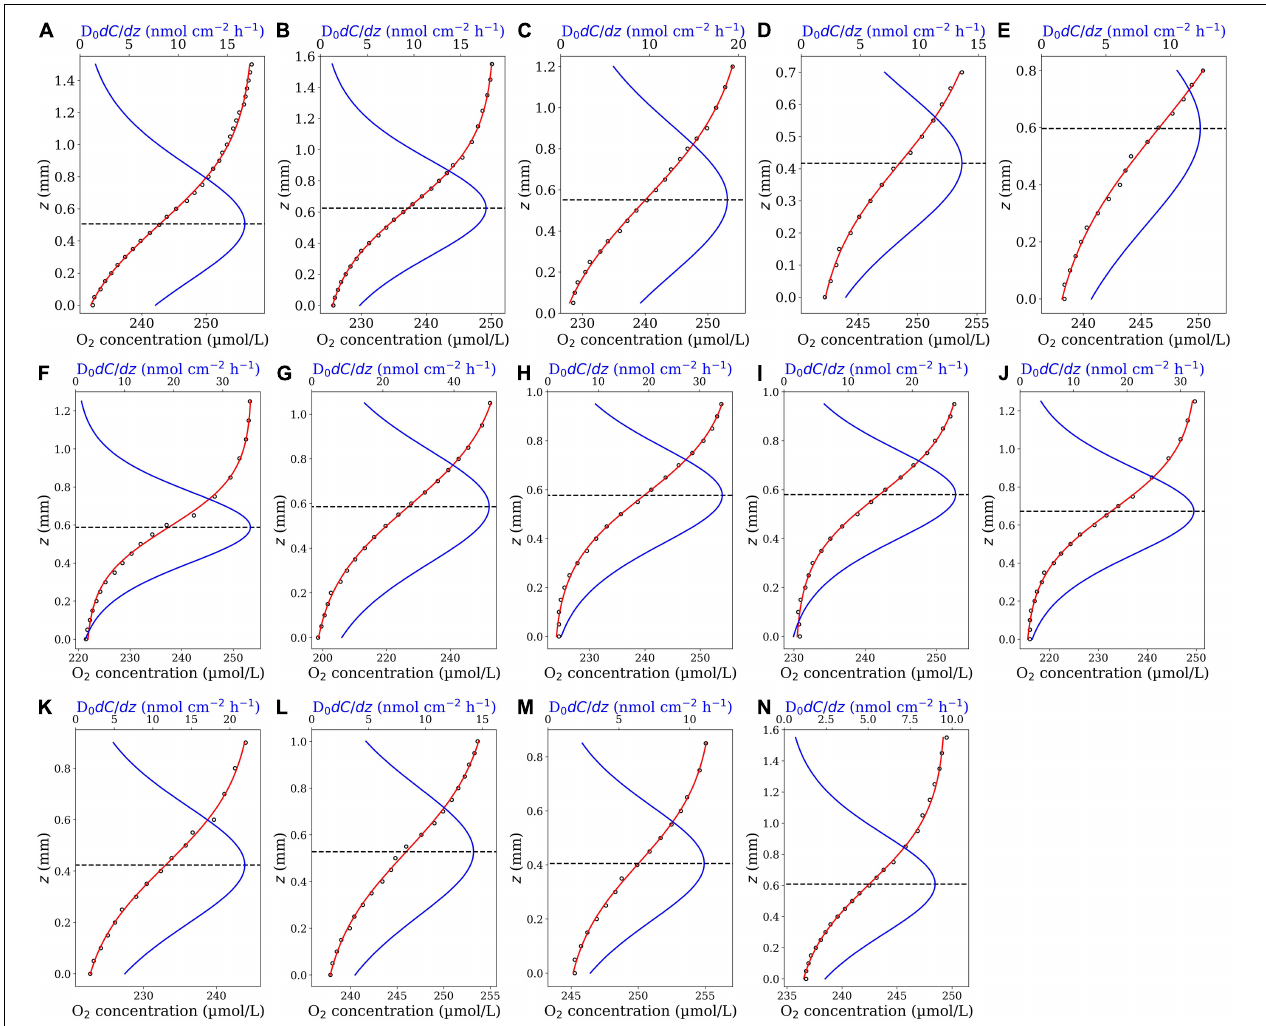
FIGURE 2 | O 2 concentrations profiles (close circles) measured in sinking diatom aggregates (A–E) , coccolithophore aggregates (F–J) and mixture of diatom and coccolithophore aggregates (J–N) (Iversen and Ploug, 2010). The highest and lowest concentrations represent the onset of concentration variation in the ambient water above the aggregate (ambient concentration) and the concentration in the middle of each aggregate (minimum concentration), respectively. The origin of the z -axis ( z = 0) has been set at the middle of the aggregates with the positive direction upwards. The red curves are the best fit of the first fit-model function (Eq. 4). The blue curves represent the corresponding diffusive flux functions (Eq. 5 multiplied by the diffusion coefficient). The horizontal dashed lines identify the position of aggregate-water interface (corresponding to the maximum diffusive fluxes).